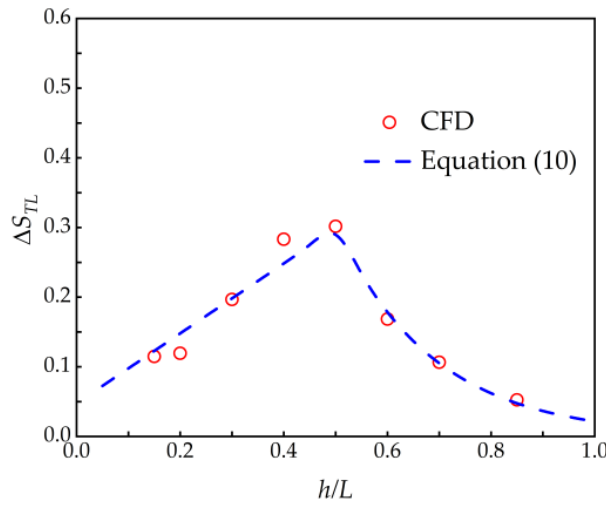
Figure 13. The change in speedup ratio at the hilltop with the slope of the hill ( Z / h = 0.0133).